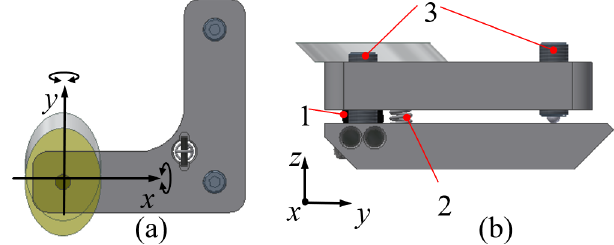
Figure 3. Mirror adjustment unit in top view (a) and side view (b) . Note: 1 – support ball; 2 – spring; 3 – fine adjustment screws.